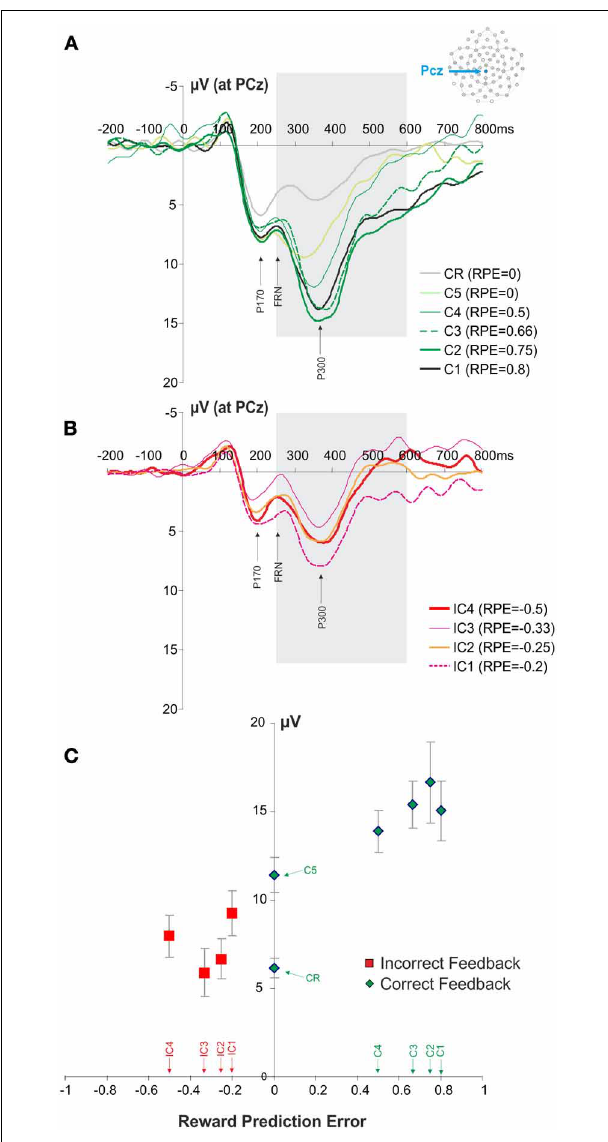
FIGURE 4 | ERPs recorded at PCz at the presentation of the feedback and P300 modulation. (A,B) Average ERPs elicited by the different correct and incorrect feedbacks. The panel (A) illustrates the signals recorded for the different positive feedbacks (C1, C2, C3, C4, C5, CR). Similarly the panel (B) illustrates the signals recorded for the different negative feedbacks (IC1, IC2, IC3, IC4). The gray box is indicating the time windows of interest in which we measured the amplitude of P300 ( + 200 to + 350ms post feedback). (C) Modulation of P300 amplitude according to RPE quantified at PCz. Red and green symbols represent RPE values associated with negative and positive feedbacks, respectively. Feedback types corresponding to the different RPE values are indicated above the horizontal